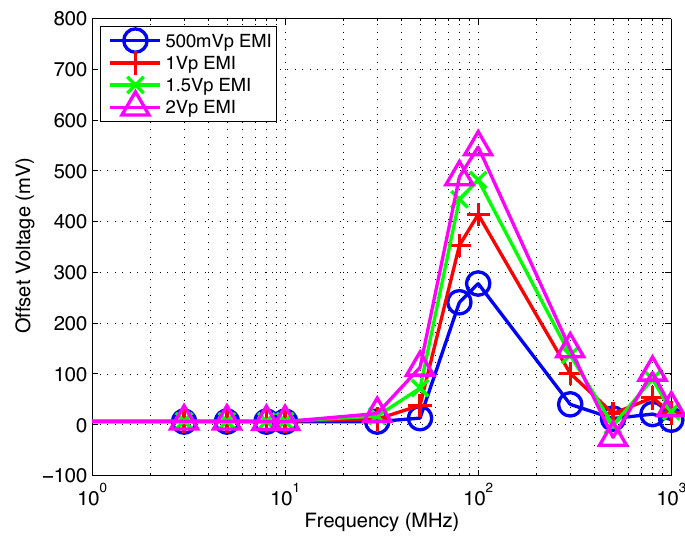
Figure 5. EMI induced offset in NE5534: interferences coupled to the output pin.